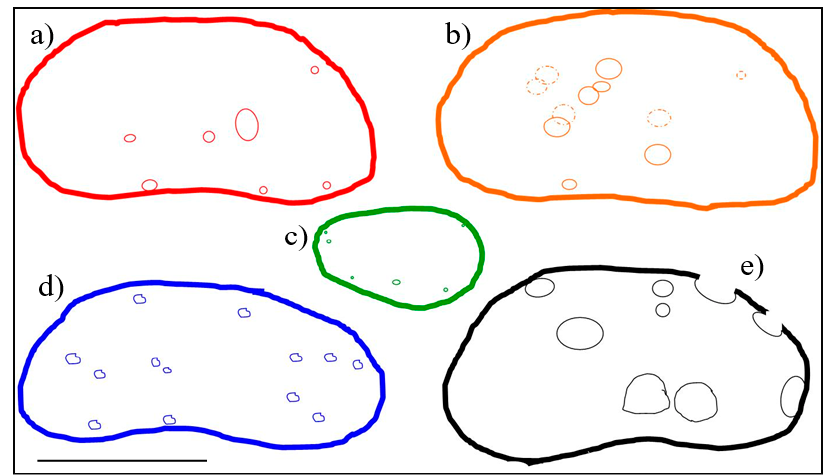
Figure 9. Profiles of the Cava Nuova valves and distribution of microborings. The dashed outline indicate the failed/or non penetrative predations. Scale bar = 500 μ m. ( a ) Caspiocypris basilicii , female left valve. ( b ) Caspiocypris tiberina , female left valve. ( c ) Cytherissa lacustris , left valve. ( d ) Caspiocypris tuderis , female right valve. ( e ) Caspiocypris basilicii , female right valve .